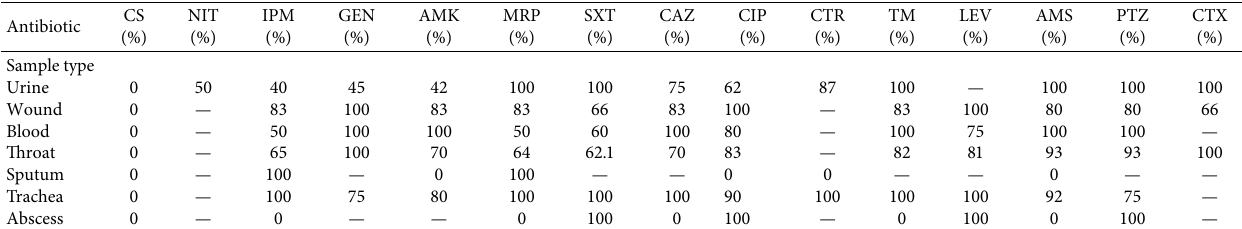
CS, colistin; NIT, nitrofurantoin; IPM, imipenem; GEN, gentamicin; AMK, amikacin; MRP, meropenem; SXT, trimethoprim-sulfamethoxazole; CAZ, ceftazidime; CIP, ciprofloxacin; CTR, ceftriaxone; TM, tobramycin; LEV, levofloxacin; AMS, ampicillin-sulbactam; PTZ, piperacillin-tazobactam; CTX,